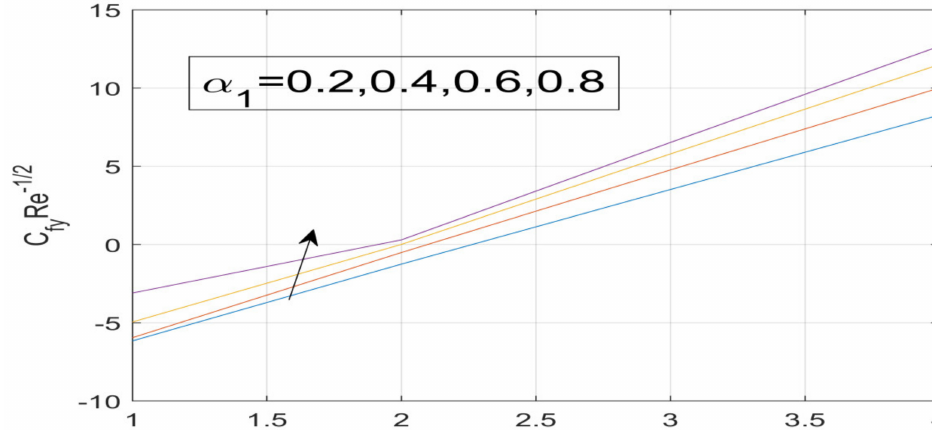
Figure 23. Influence of α _1 on gˆ (cid:48) (0).